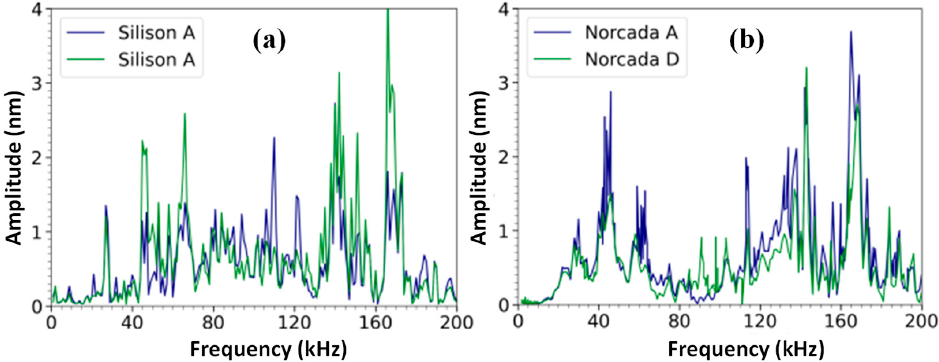
Figure 6. Acoustic spectra of the Silison A, Norcada A, and Norcada D membranes show multiple peaks over the frequency range of 0 − 200 kHz. ( a ) Repeated measurements of the Silison A membranes 2 h apart. ( b ) The Norcada A and Norcada D membranes show repeatable results on different days.